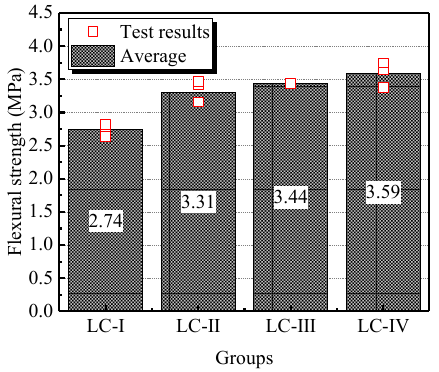
Figure 4. Flexural strength of specimens in four groups.